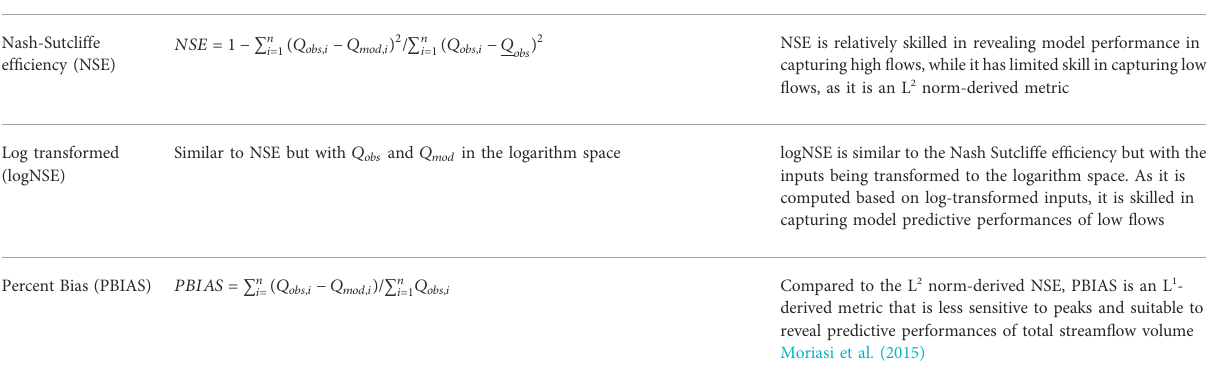
TABLE 1 List and description of predictive performance evaluation metrics in HydroBench. Here, Q represents stream fl ow, an example of the dependent variable, P represents precipitation, as an example of an input fl ux variable, mod = model, and obs = observed. Name